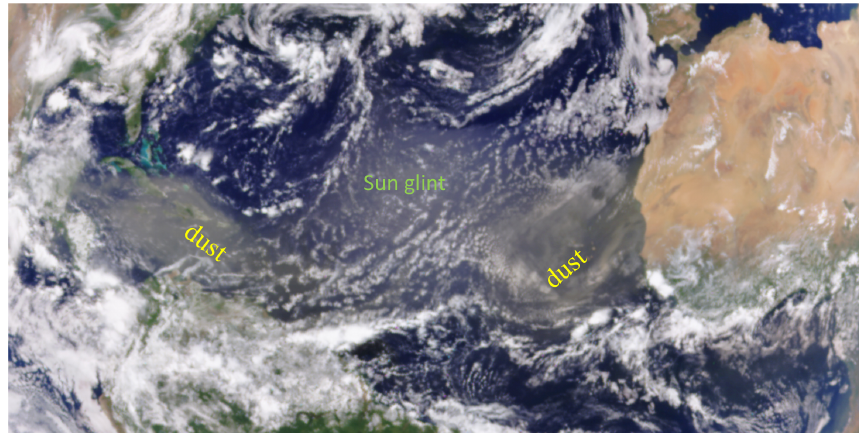
Figure 1. A panorama of dual dust plumes from 2.5 × 10 9 m above the Earth’s surface snapped by the EPIC/DSCOVR at 14:47:32GMT on 23 June 2020 (https://epic.gsfc.nasa.gov, last access: 20 January